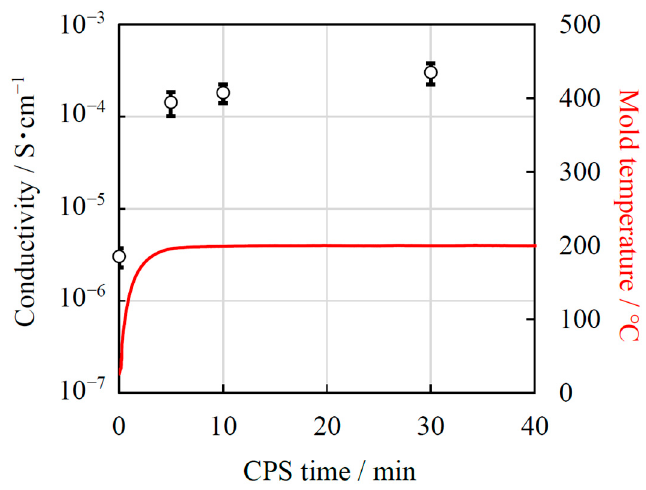
Figure 5. Conductivity of LATP sheets at 25 °C obtained from impedance measurements and mold temperature as functions of CSP time.